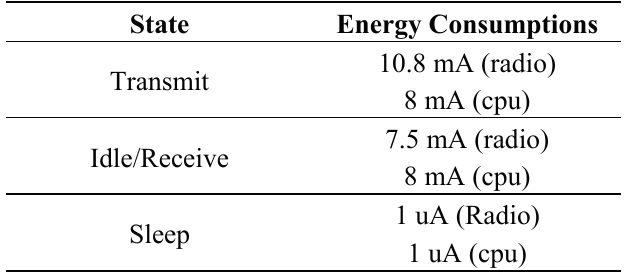
Table 1. Power measurements of a sensor node